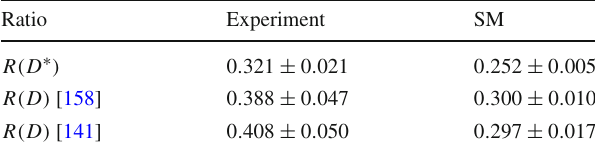
Table 2 Average experimental values [141,158] and SM predictions